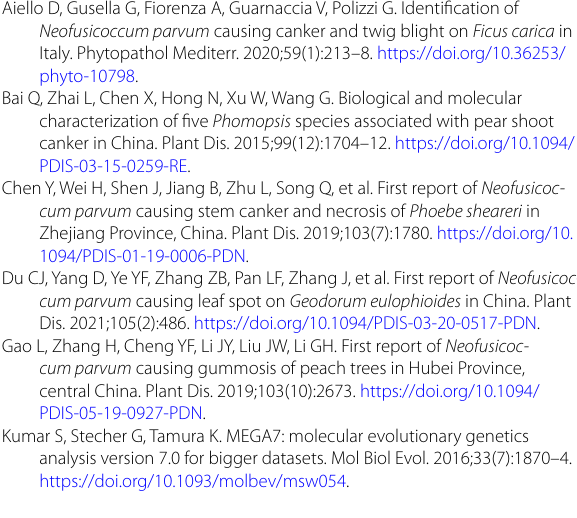
Additional file 1: Table S1. Spore size of N. parvum strains. Table S2. Control effect of several fungicides against N. parvum isolates. Additional file 2: Figure S1. Phylogenetic tree of N. parvum isolates based on ITS